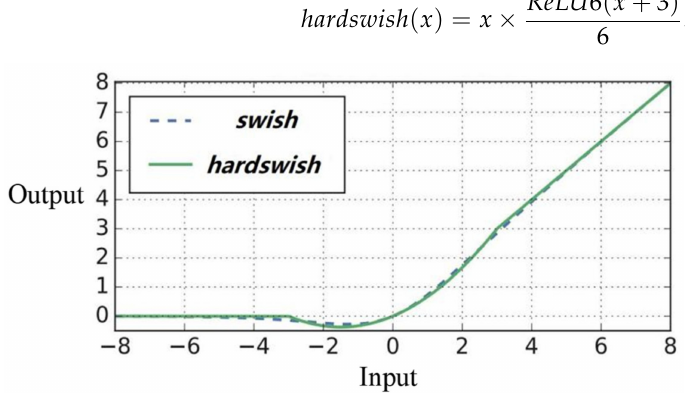
Figure 4. The swish and hardswish nonlinearity